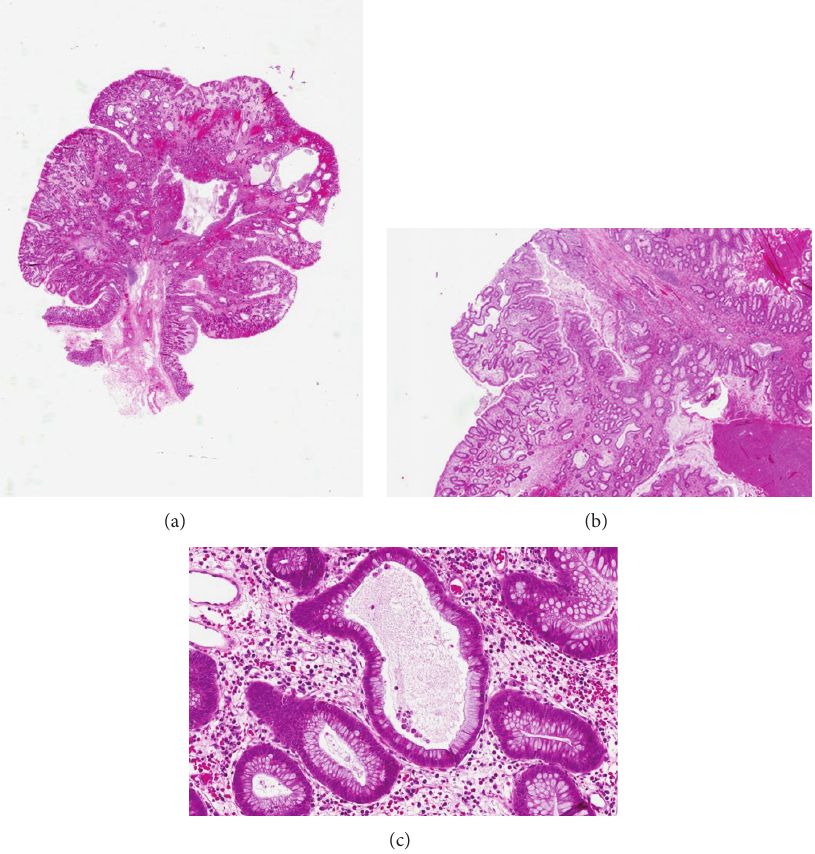
Figure 2: (a) Juvenile polyp surface with tortious glands of varying size focally filled with mucus and lined by columnar epithelium. Note the oedematous and inflamed stroma. (b) No smooth muscle fibres are detected. An oedematous and inflamed stroma with collagen fibers. (c) High magnification of part of the juvenile polyp with marked congestion and dilated glands with prominent mucin and cell debris. Infiltration of lamina propria with large amounts of mononuclear cells mainly plasma